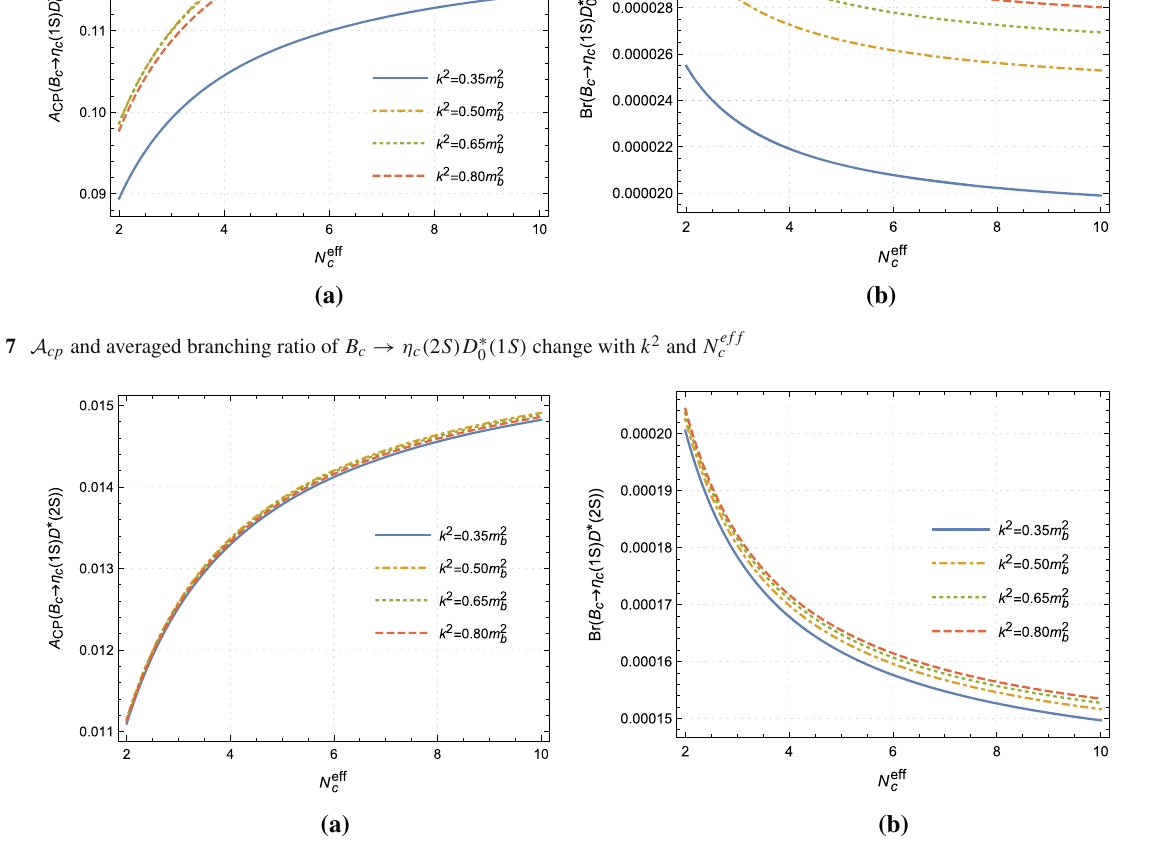
Fig. 7 A cp and averaged branching ratio of B c → η c ( 2 S ) D ∗